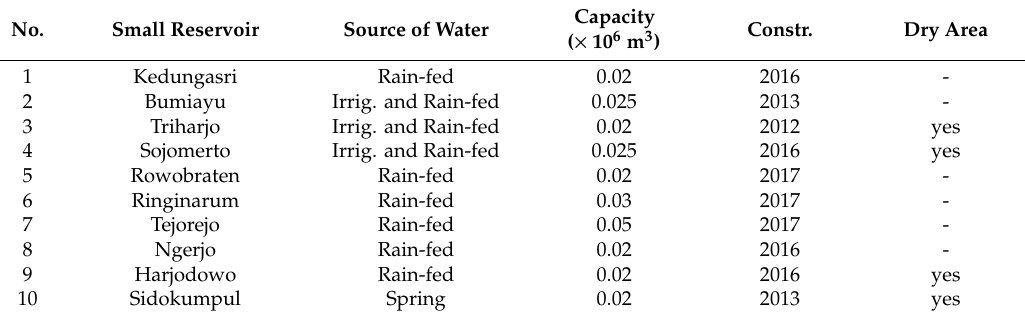
Table 1. Constructed small reservoirs in the river basin.